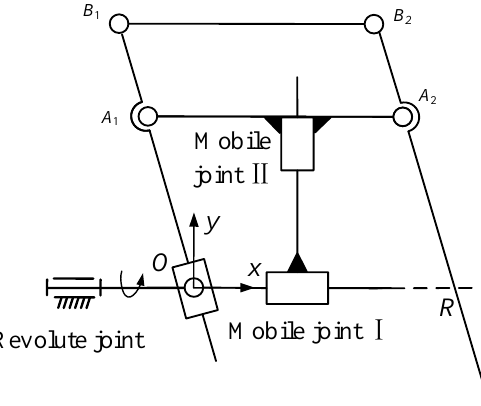
Figure 2. A 3-DOF RCM mechanism.